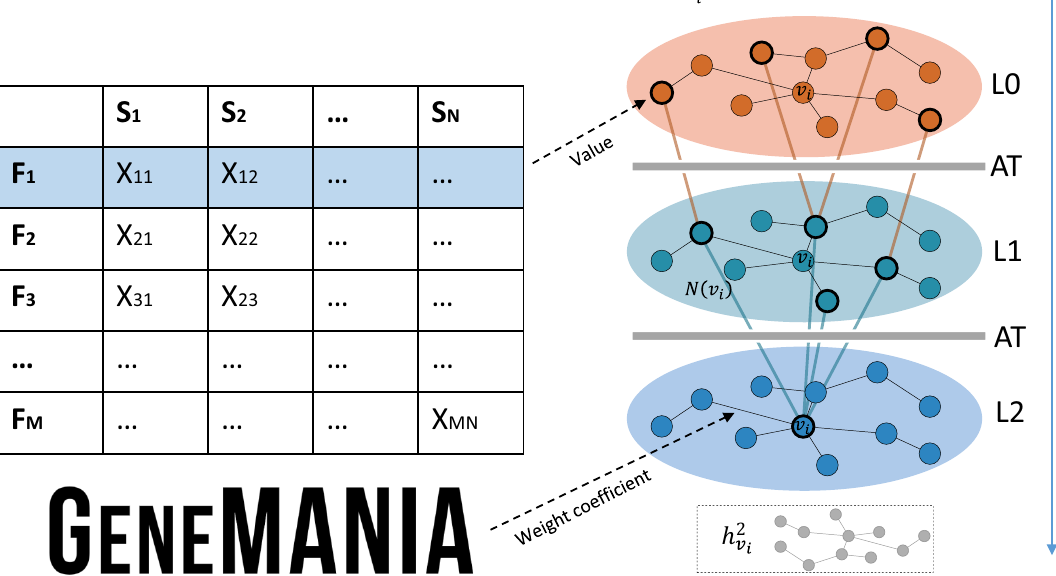
Figure 2. Flow chart of GNN framework visualization. The initial information of nodes is obtained from microarray data, and the edge information is obtained from GeneMANIA. L denotes the number of layers, and AT denotes the attention layer, which is used to process the edge weights. The figure shows a three- layer information propagation aggregation framework. node V i i obtains a hidden state vector h representation capability after continuously aggregating information from first-order neighborhood